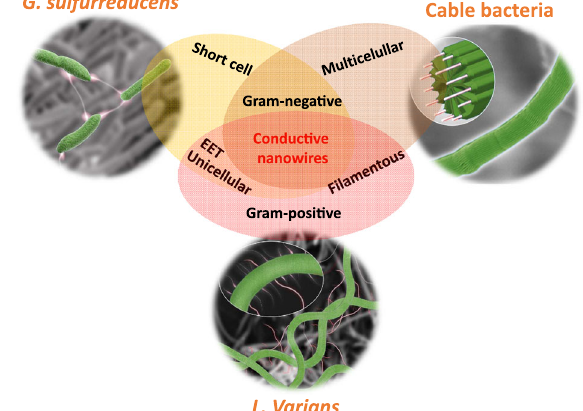
Fig. 5 A comparison among the conductive networks of Geobacter ,